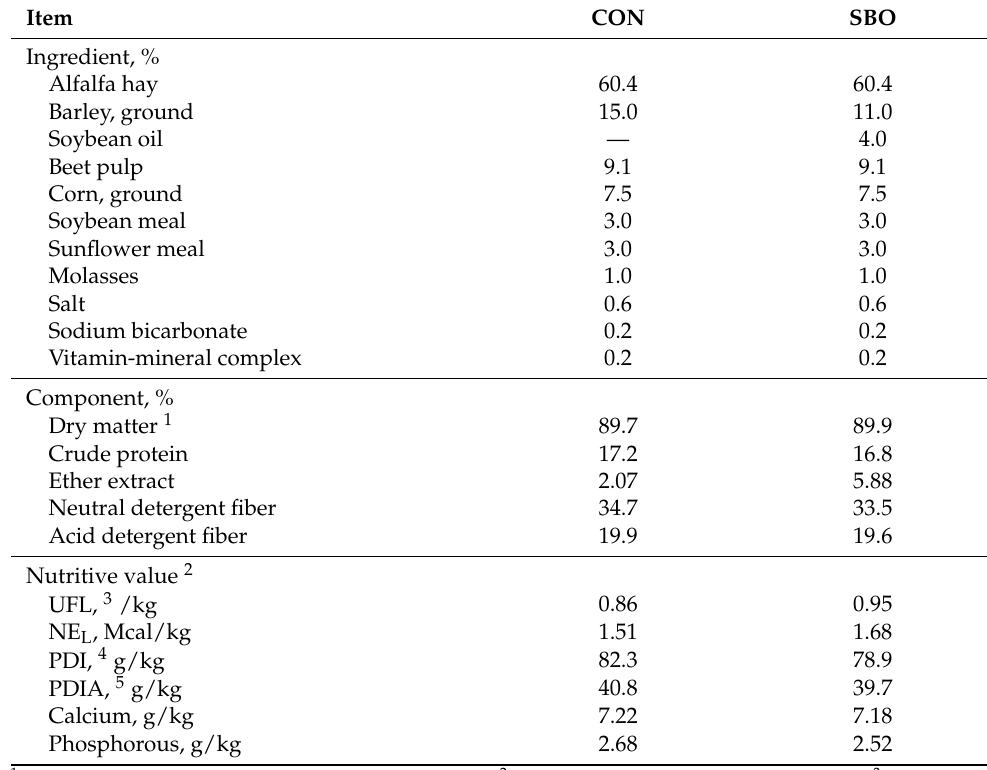
Table 1. Ingredients and nutrient composition of the control (CON) diet without supplementation and the supplemented diet with 4% sobybean oil (SBO). Values are expressed on dry matter